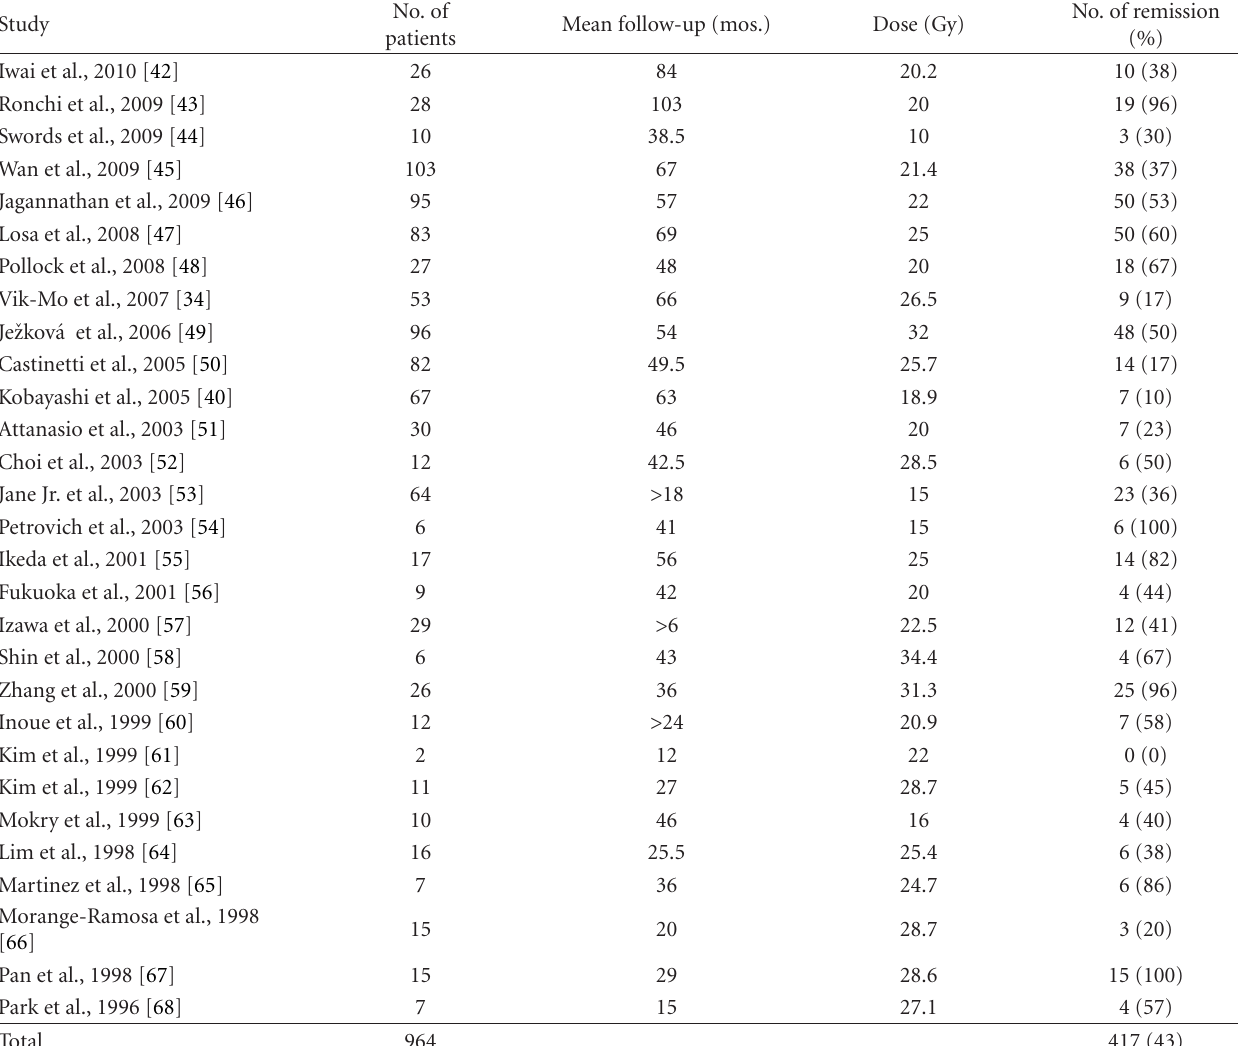
Table 1: Studies of GKS for